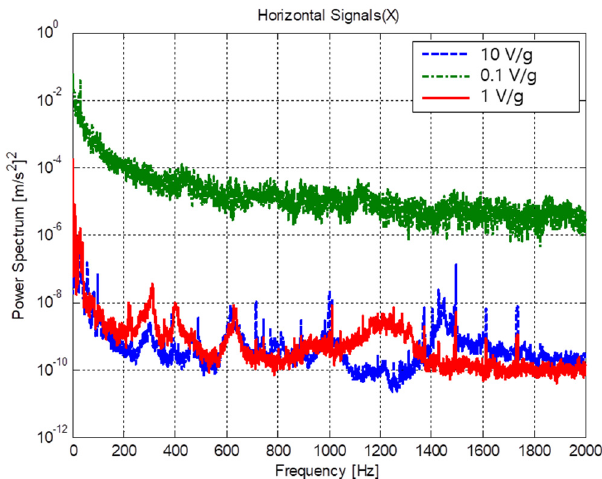
Figure A1. Environmental vibrations measured using accelerometers with sensitivities of 10 V / g (blue dashed line), 1 V / g (red line), and 0.1 V / g (green dash-dotted line).